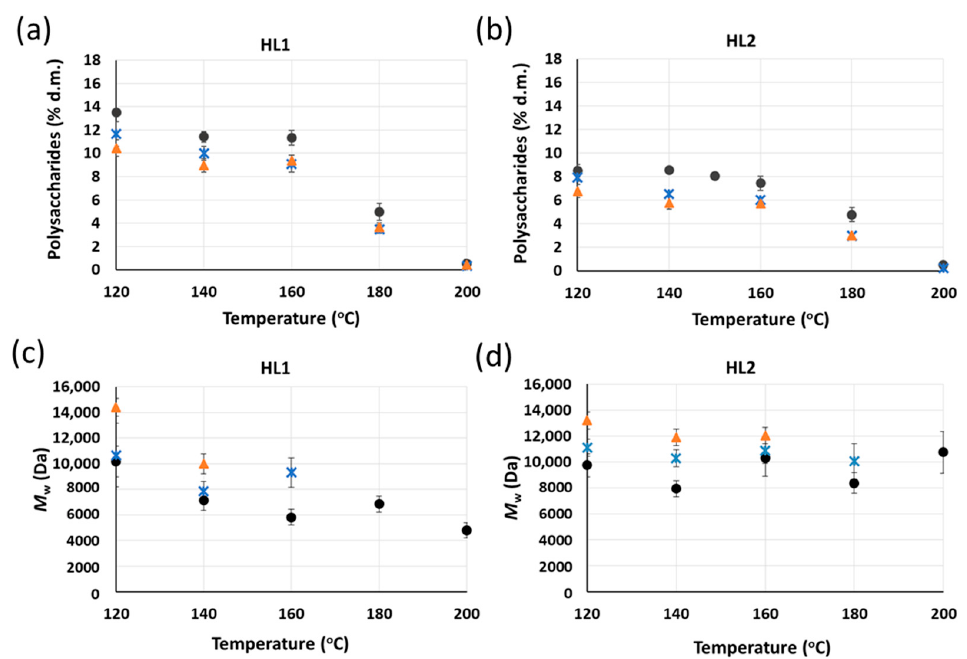
Figure 7. Concentration of polysaccharides in ( a ) HL1 and ( b ) HL2 and average M w of ( c ) HL1 and ( d ) HL2 lignins after acid hydrolysis treatment using 0.2 M H 2 SO 4 at different temperatures and time (  1 h;  6 h;  22 h). Yields of purified lignins ≥ 95%. Standard deviation error bars of dupli- and time ( • 1 h; 6 h; 22 h). Yields of purified lignins ≥ 95%. Standard deviation error bars of cate experiments. duplicate